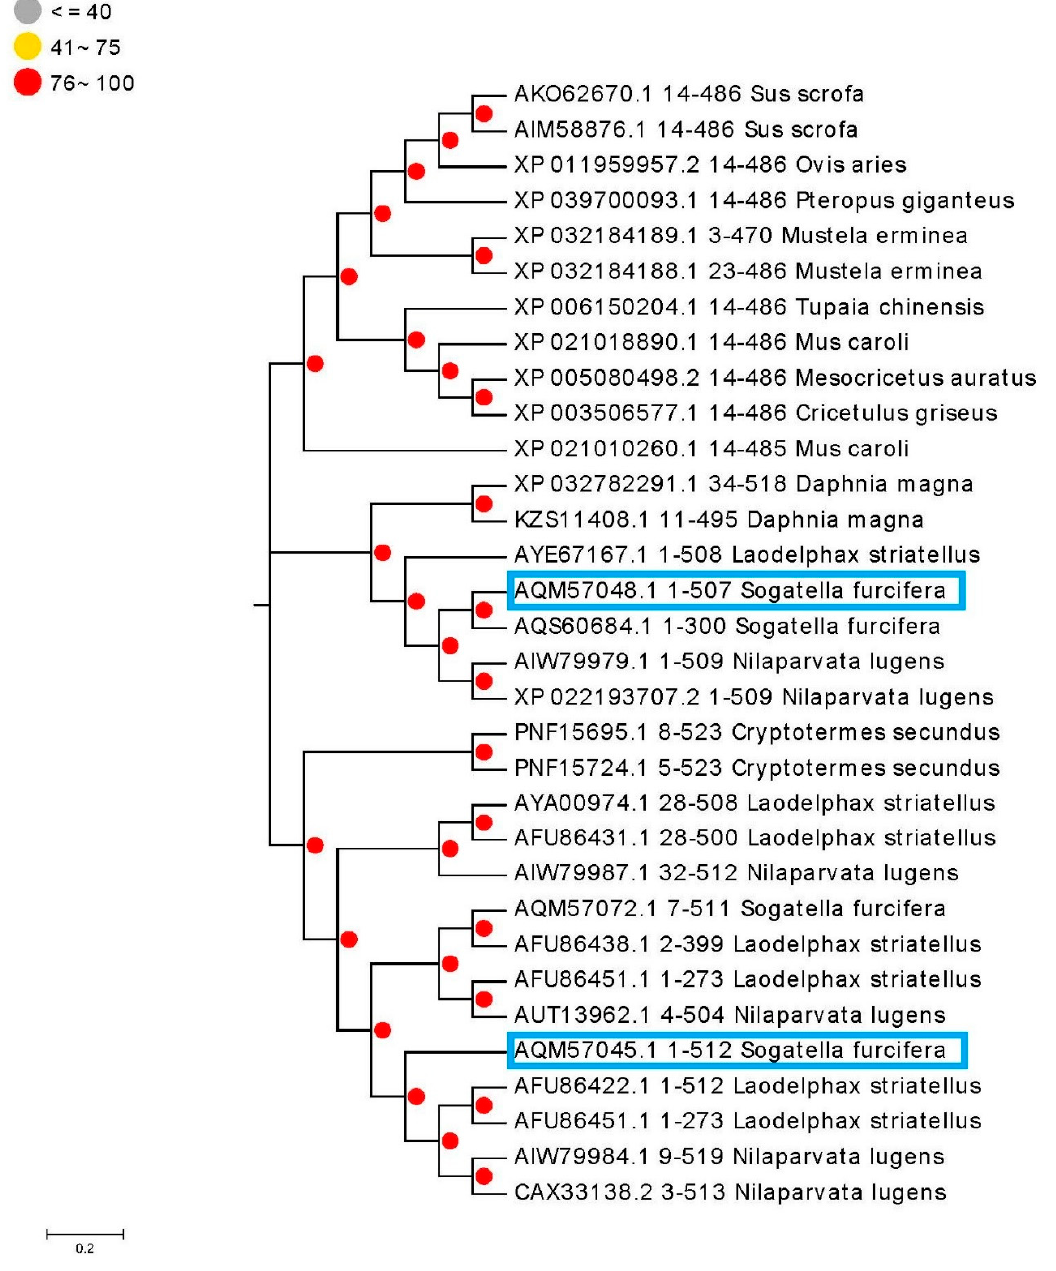
Figure 3. Phylogenetic relationship among CYP6CS3 and CYP408A3 , other insect P450s. Two selected and validated P450 genes have been labeled with blue boxes (The AOM57048.1 represents the P450 gene CYP408A3 and the AOM57045.1 represents the CYP6CS3). The GenBank accession numbers are shown before the P450 names. The phylogenetic tree was inferred using Neighbor-Joining. The scale bar indicates 0.1 amino acid substitutions per site. The percentage of the replicate trees in which the associated taxa clustered together in the bootstrap test (1000 replicates) is shown next to the branches. The phylogenetic analyses were conducted in MEGA 7.0.